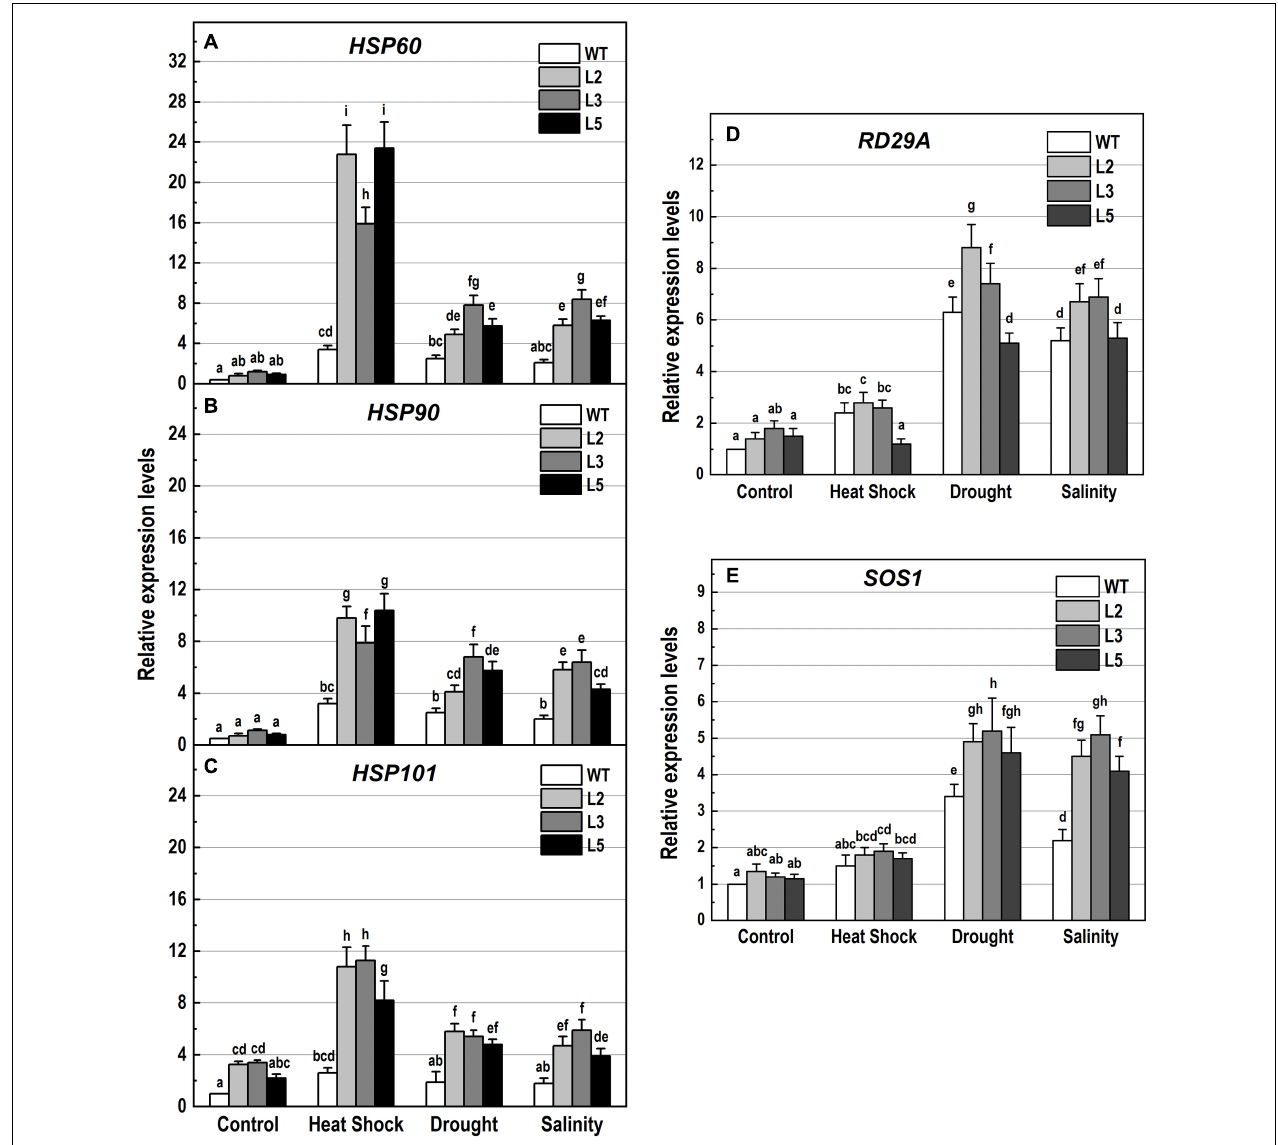
FIGURE 10 | Analysis of the expression levels of genes encoding the heat shock proteins HSP60 , HSP90 and HSP101 , and the stress-responsive genes RD29A and SOS1 in 10-day-old wild-type seedlings and transgenic lines overexpressing NMig1 (L2, L3, and L5) after exposure to heat shock, drought and high salinity: (A) HSP60 , (B) HSP90 , (C) HSP101 , (D) RD29A , and (E) SOS1 . Expression levels were normalized to those of EF1a and CDKA1;1 , as described in section “Materials and Methods.” Data represents the mean values ± SE from at least three biological replicates. Different lowercase letters indicate statistically significant difference ( p ≤